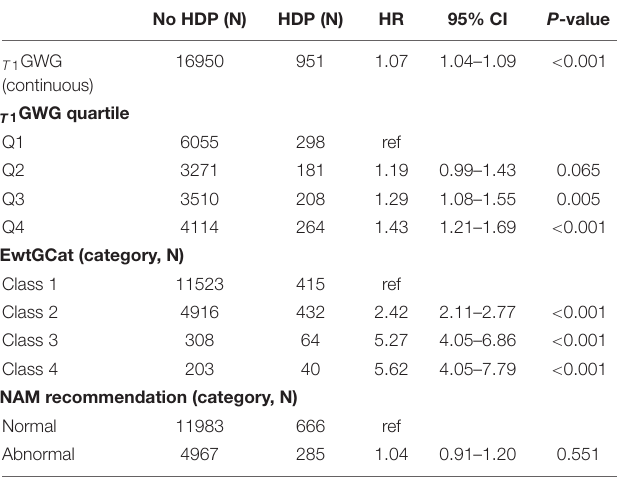
TABLE 2 | Hazard ratios for the association between the first trimester gestational weight gain ( T 1 GWG) and hypertensive disorders of pregnancy